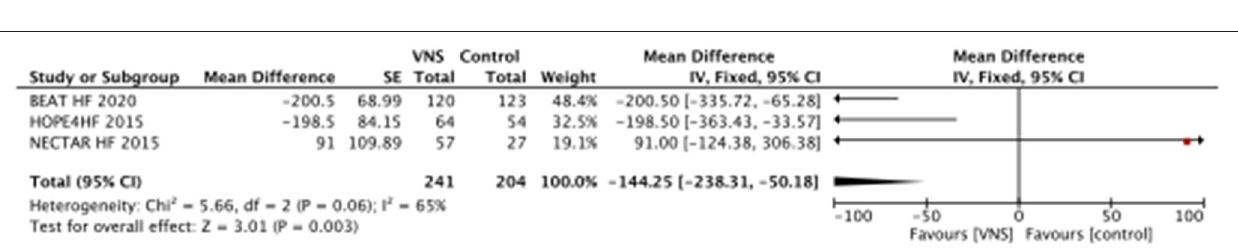
improvement in the functional NYHA class, QoL, 6-min